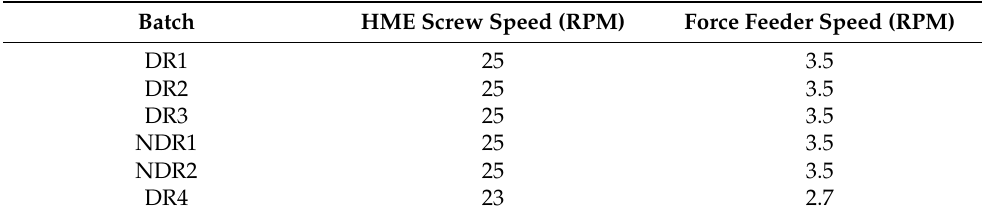
Table 3. Powder storage conditions before extrusion and hot-melt extrusion (HME) parameters in function of the